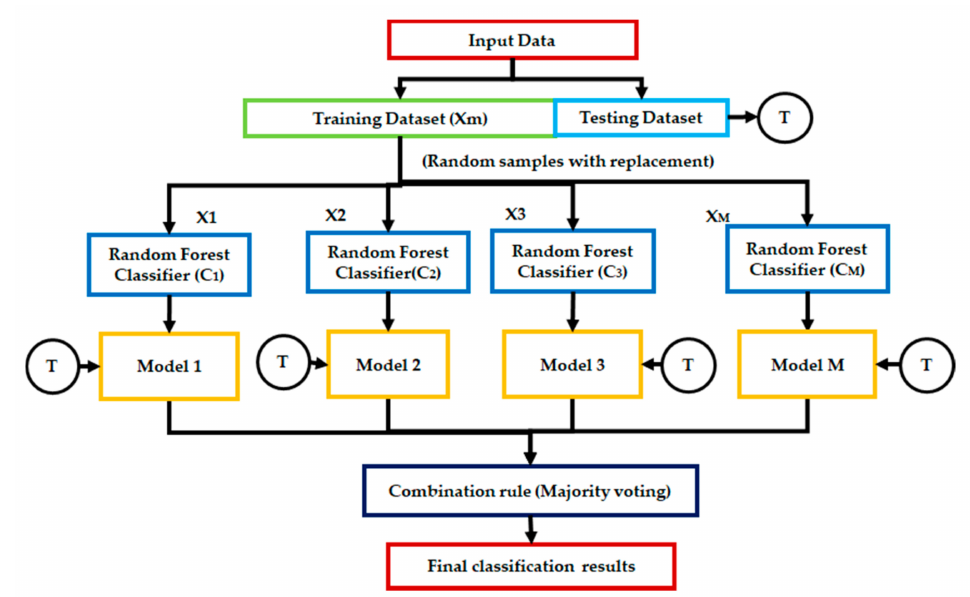
Figure 2. A generalized workflow of the Random Forest